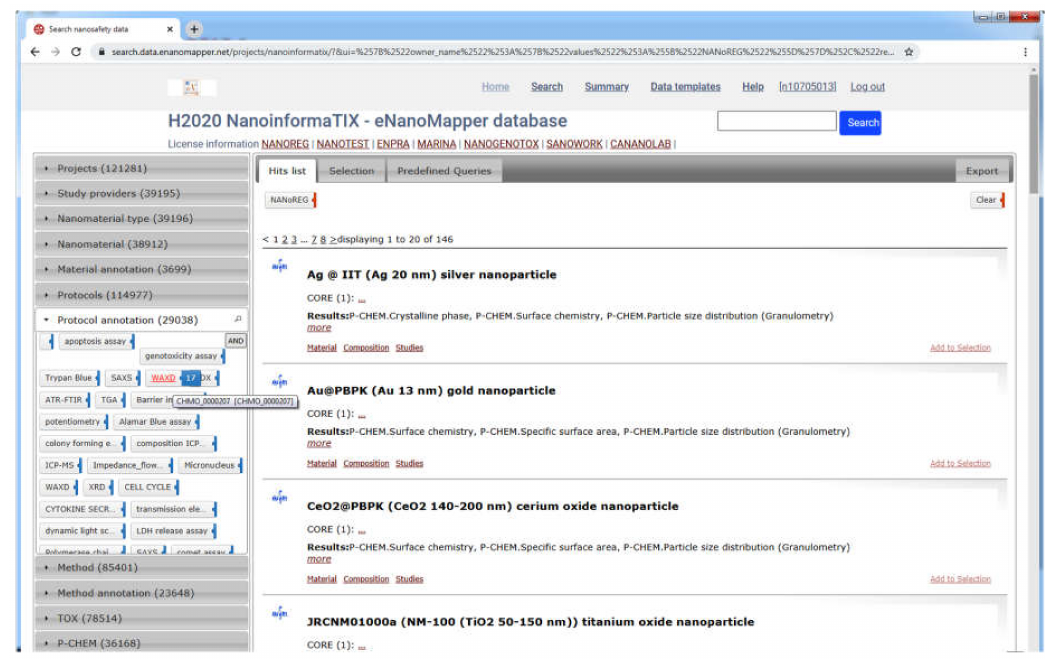
Figure 11. NanoInformaTIX–eNanoMapper database free text and faceted search interface, aggregating data from completed projects (NANoREG, ENPRA, MARINA, NanoGenotox, Sanowork) and US